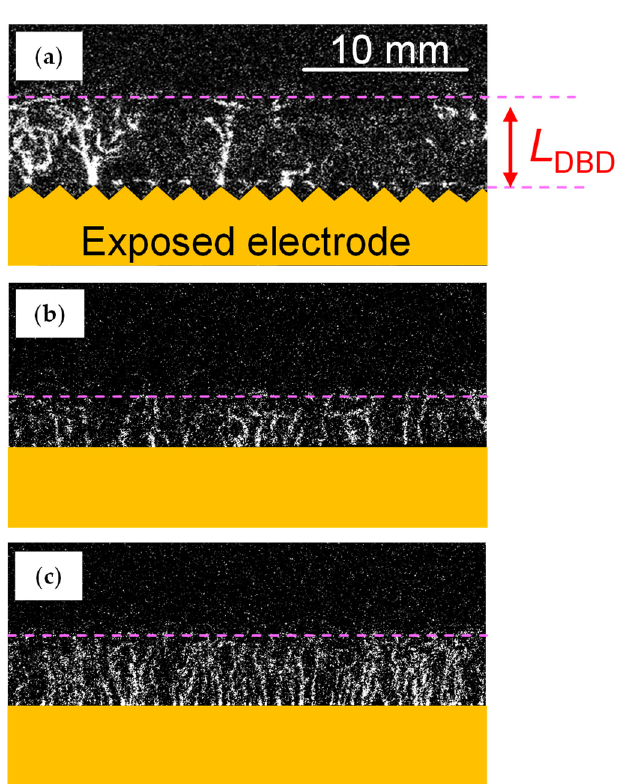
Figure 11. DBD emission images of section (V), shown in Figure 12, for ( a ) string-array-type PA with 12 wires, ( b ) reference, and ( c ) discretized sheet-type PAs for P PA ≈ 115 W. L DBD defined as plasma length in section (V) and power consumption are evaluated as ( a ) 5.1 ± 0.6 mm, 115.6 W/m; ( b ) 3.3 ±